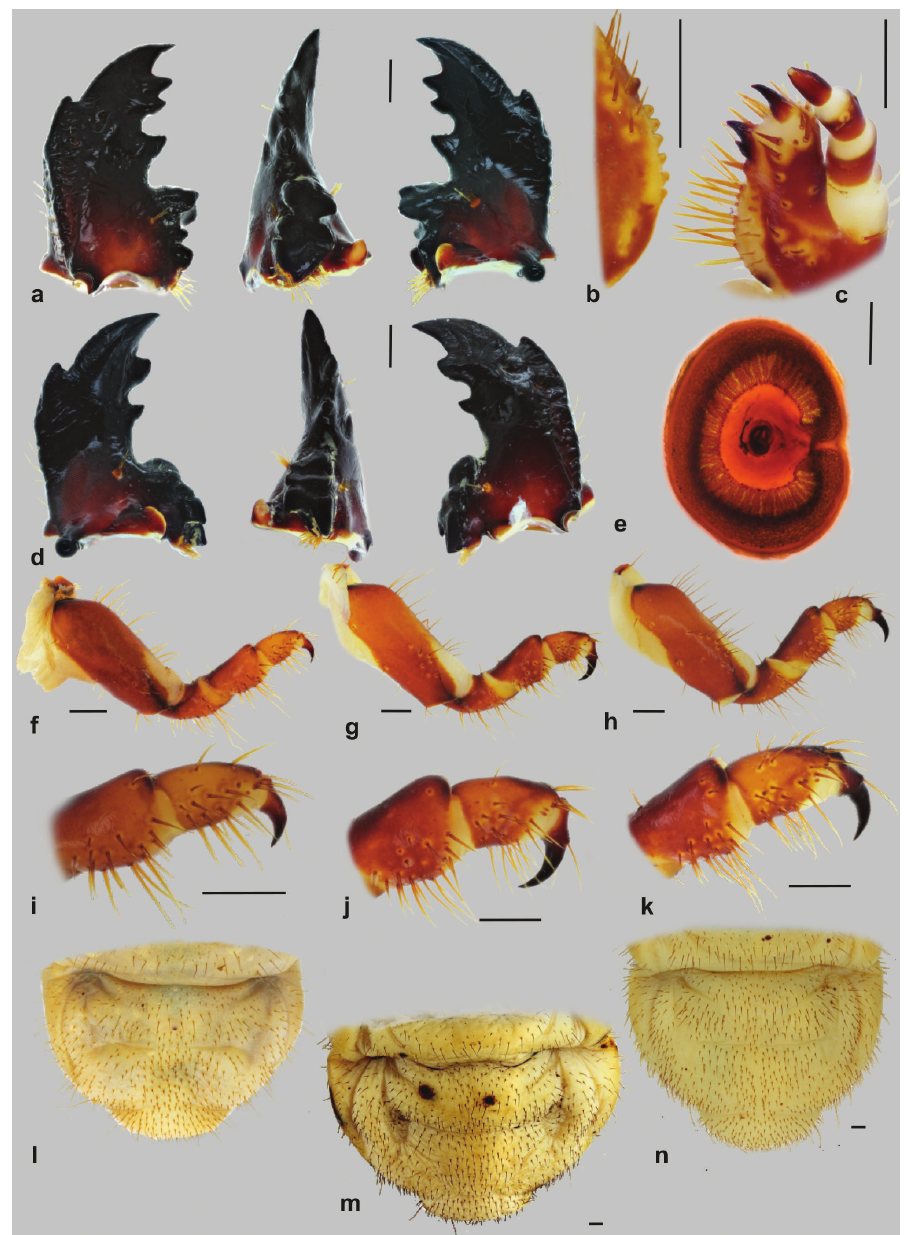
Figure 3. Immature stages of the genus Goliathus : A G. orientalis, left mandible, dorsal, medial and ventral aspect B G. orientalis, maxillar stridulatory teeth, lateral aspects C G. orientalis, detail of mala and unci, ventro-lateral aspect D G. orientalis , right mandible dorsal, medial and ventral aspect E G. albosigna- tus , thoracic spiracle F–H prothoracic leg ( F G. albosignatus G G. goliatus H G. orientalis ) I–J tibiotarsus and preatarsus (claw) ( I G. albosignatus J G. goliatus K G. orientalis ) L–N raster ( L G. albosignatus M G. goliatus N G. orientalis ). Scale bars: 1mm (when not otherwise specified), 0.1 mm ( A, B, C ); 0.5 mm ( D